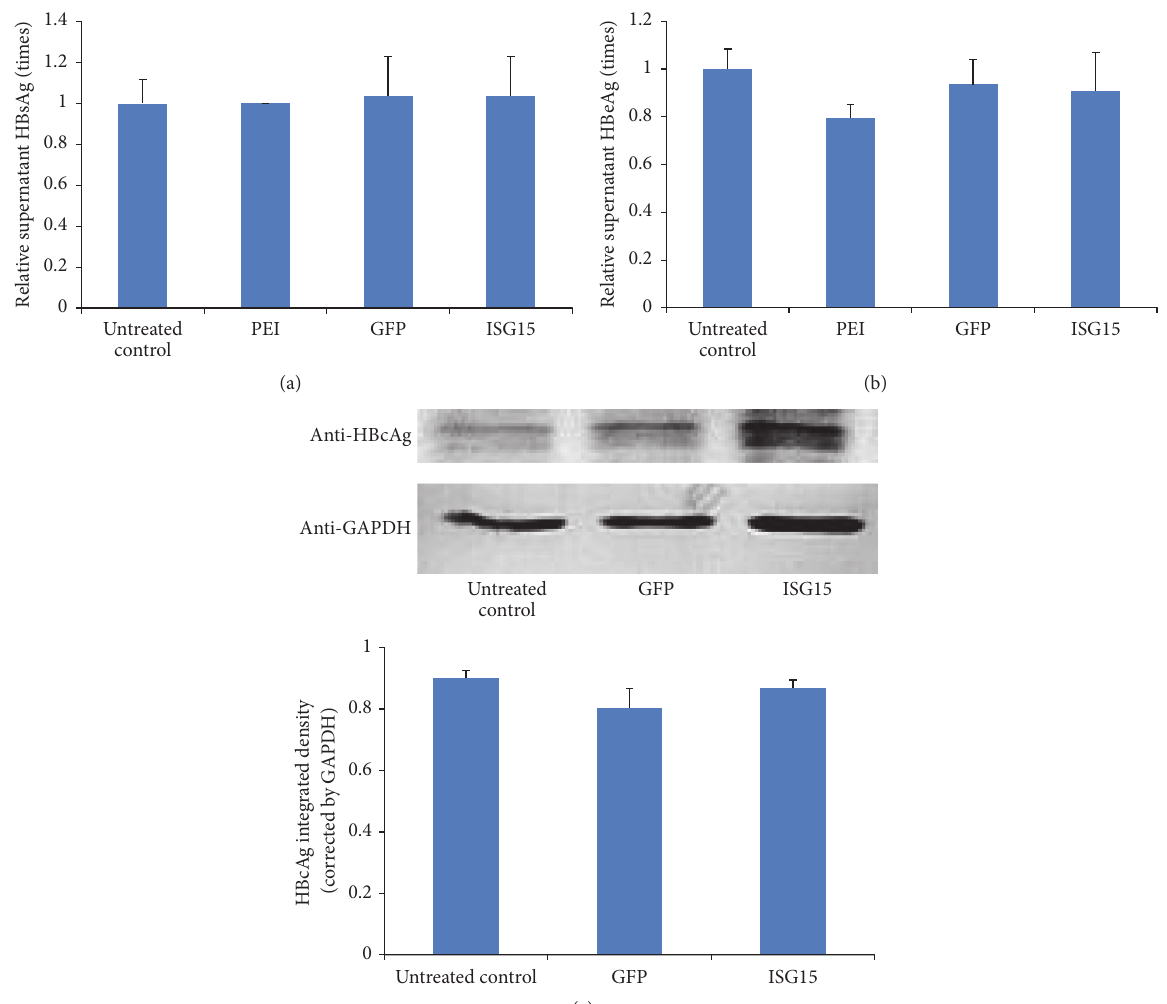
Figure 3: HBV protein expression after ISG15 overexpression . HepG2.2.15 cells were transfected with the ISG15 plasmid or GFP-expressing plasmid. (a) HBsAg and (b) HBeAg in the culture medium were detected by ELISA, respectively. (c) Intracellular HBcAg was assessed by western blot. Relative integrated density was calculated by ImageJ software and normalized by GAPDH expression. PEI, transfection regent polyethyleneimine (PEI) treatment only; GFP, transfected with 4 𝜇 g GFP-expressing plasmid; ISG15, transfected with 4 𝜇 g ISG15 plasmid. The results are presented as the means ± SD, 𝑛 ≥ 3 ; error bars indicate